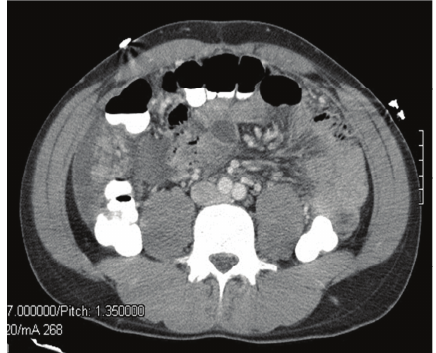
Figure 2: CT scan of the abdomen and pelvis showing ascites with di ff use nodularity of the omentum and peritoneal